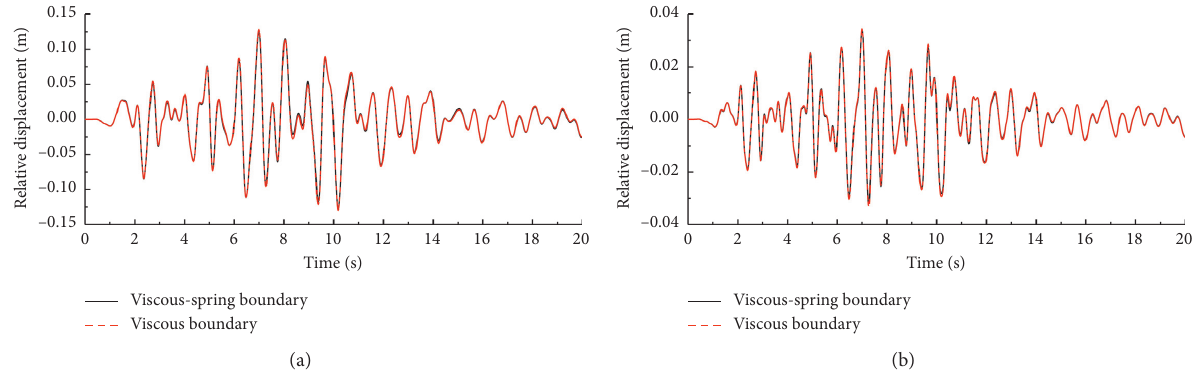
Figure 18: Time histories of relative displacements of dam crest and dam heel. (a) Horizontal displacements. (b) Vertical maximum horizontal accelerations at dam crest are 13.24 m/ s 2 and 13.32 m/s 2 , in which the relative error is 0.58%. Time histories of the hydrodynamic pressure at dam heel are plotted in Figure 20. For the solutions using the viscous- spring boundary and viscous boundary, the maximum hydrodynamic pressures at dam heel are 0.5865 MPa and 0.6071 MPa, in which the relative error is 3.50%.